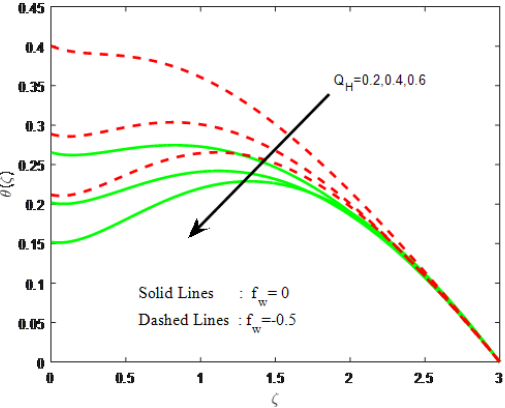
Fig. 2: The effect of Magnetic field M on velocity field profile